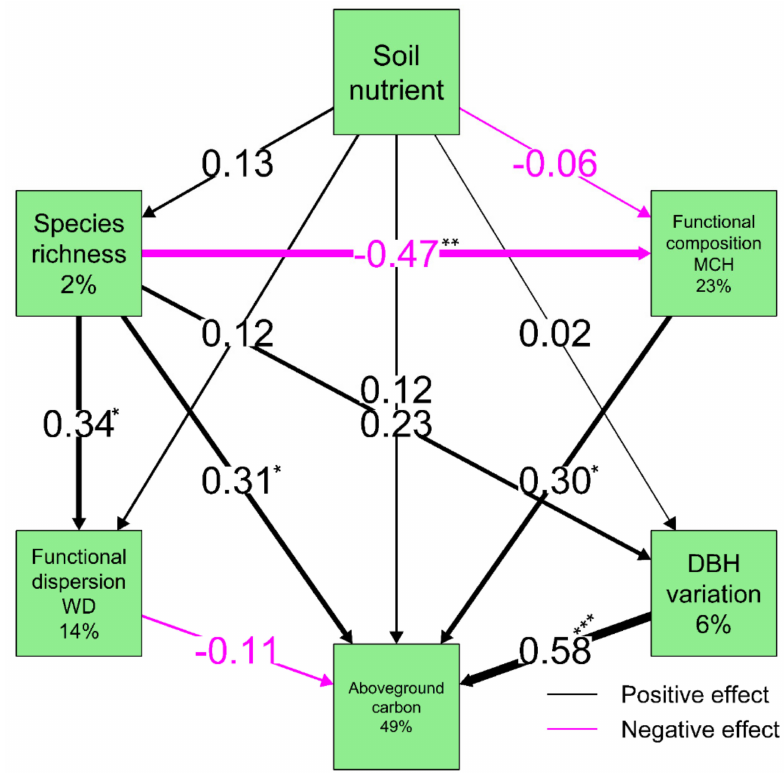
Figure 3. Underlying mechanism of the relationship between different components of biodiversity and aboveground carbon with structural equation modeling. The best fitted model with insignificant lower chi-square value ( χ 2 = 2.198, p = 0.532), along with comparative fit index (1) and Tucker–Lewis index (1) close to one and standardized root mean square residual close to zero (0.057), indicates no deviation of model from observed dataset and thus indicates good fit. The percentage value in the box of endogenous variables shows their explained variance (coefficient of determinant: R squared). The path values with a star mark indicates their significant level (***: p < 0.001, **: p < 0.01, *: p < 0.05), while the insignificant paths were indicated without a star mark ( p > 0.05). MCH: maximum canopy height, WD: wood density and DBH: diameter at breast height (at 1.30